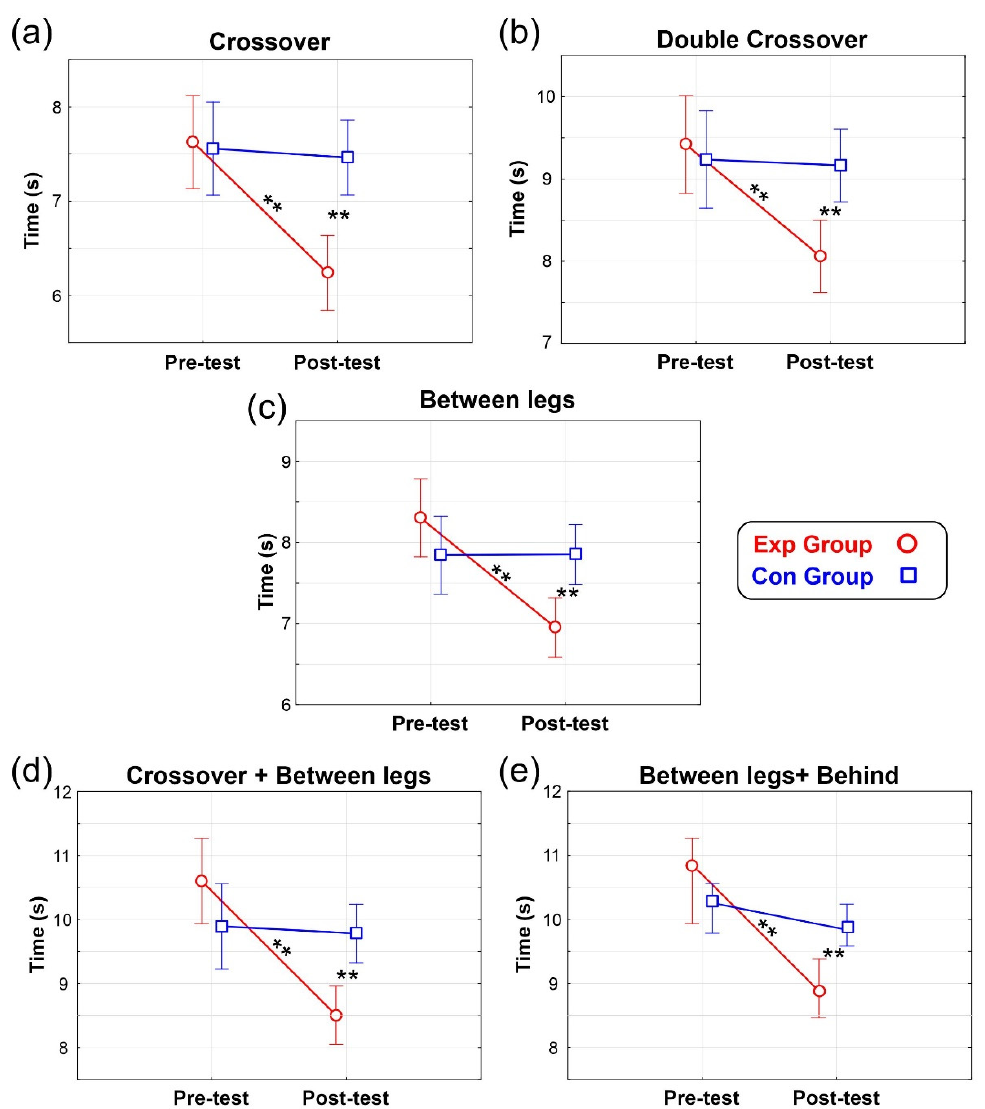
Figure 5. Basketball Dribbling Results. Vertical bars denote 0.95 confidence intervals. ** = p < 0.01. ( a ) Crossover, ( b ) Double Crossover, ( c ) Between legs, ( d ) Crossover + Between legs, ( e ) Between legs + Behind.